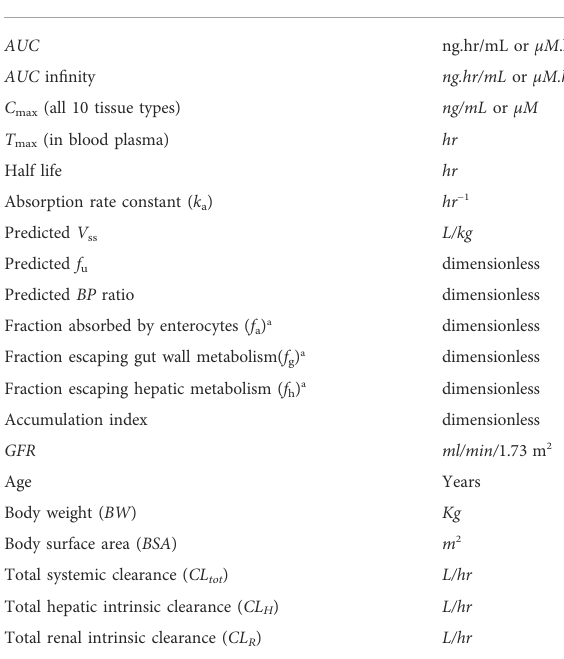
TABLE 2 The SimRFlow output parameters returned for each compound. These parameters can be referred to in the plotting functions of the data visualisation